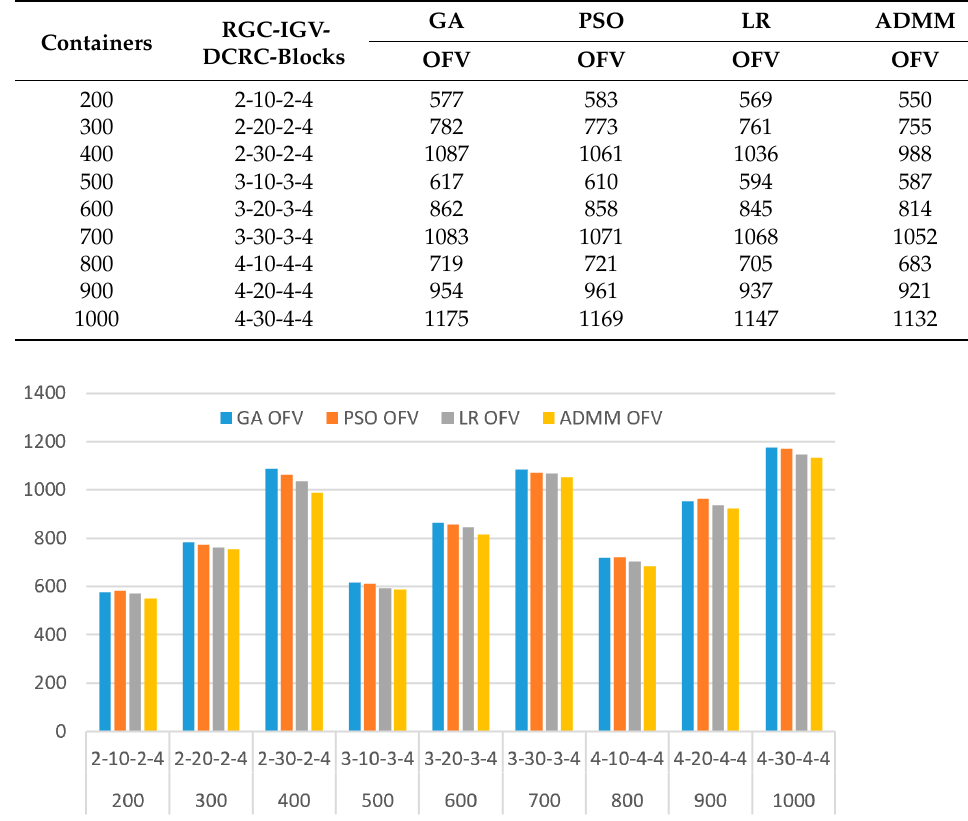
Table 6. OFV calculated by GA, PSO, LR, and ADMM.